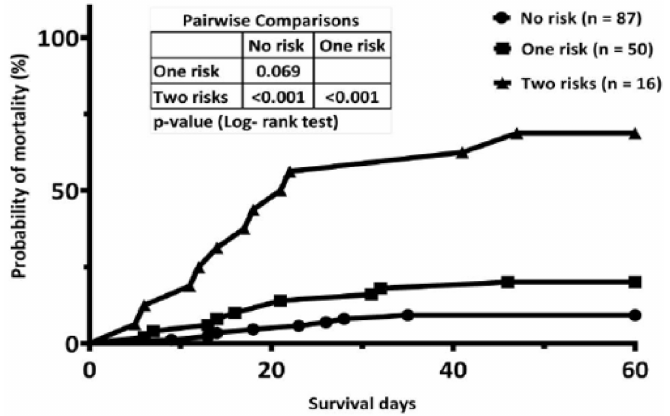
Figure 2. Comparison of the cumulative incidence of early mortality by number of risks.